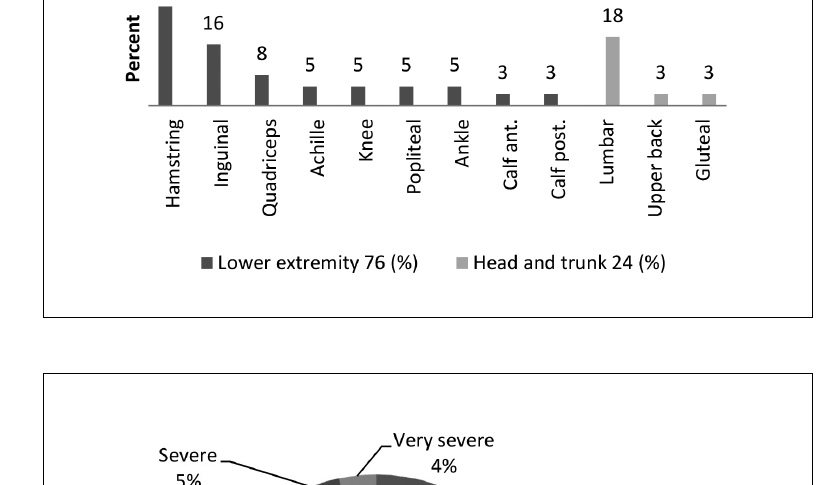
Figure 3. Injury places by body region and localization (total injuries of sprinters)